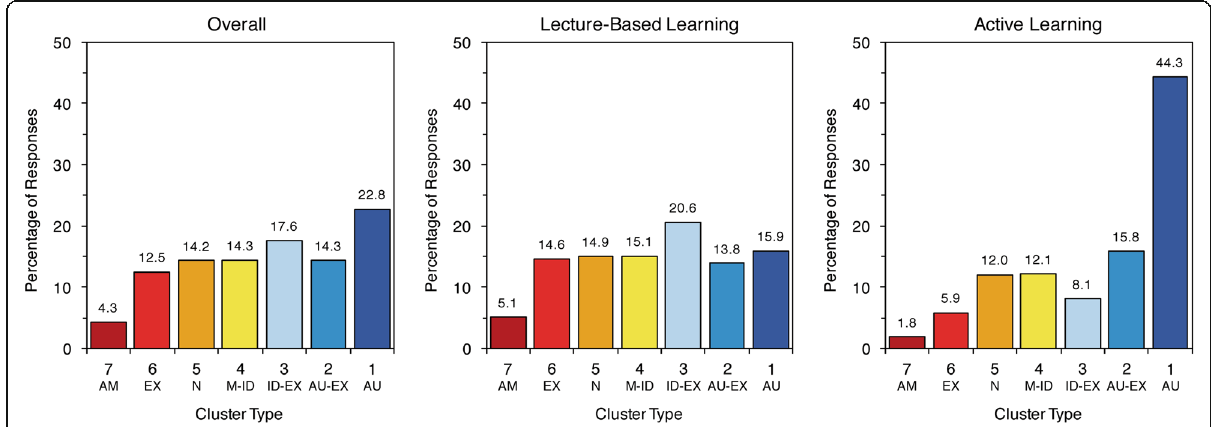
Fig. 2 Overall distribution of motivational responses in STEM college courses (left), and differences in cluster distributions for lecture-based (middle) and active pedagogies (right). Clusters are arranged from lowest SDI (left) to highest SDI